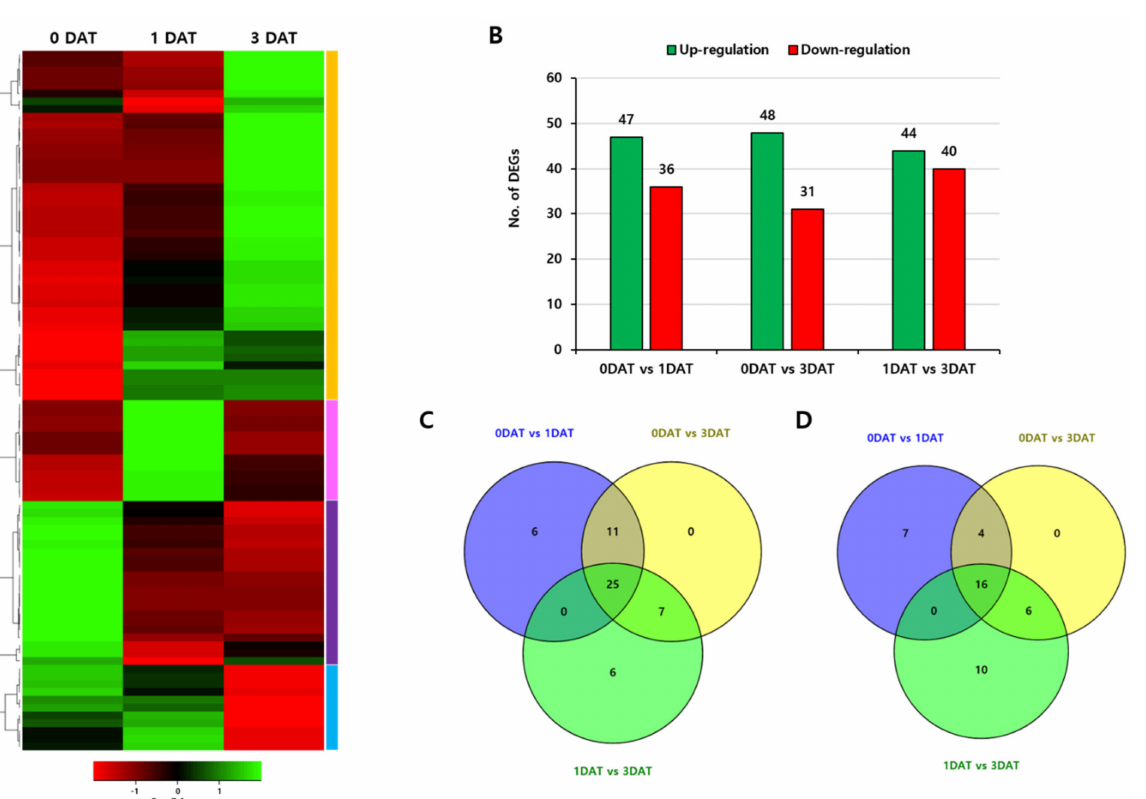
Figure 5. Expression patterns of 77 rice U-box gene family members in leaves under drought stress. ( A ) Heatmap showing expression of total differential expressed genes with increased or decreased trend under drought treatment conditions. ( B ) Total number of upregulated and downregulated genes. ( C ) Venn diagram of upregulated genes in the two samples vs. control. ( D ) Venn diagram of downregulated genes in the two samples vs. control. Two samples are 1 DAT and 3